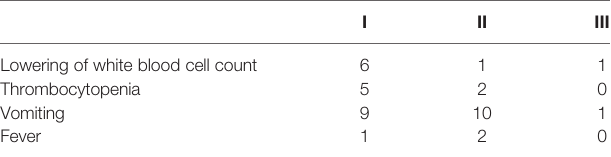
TABLE 5 | Adverse reactions after arterial infusion